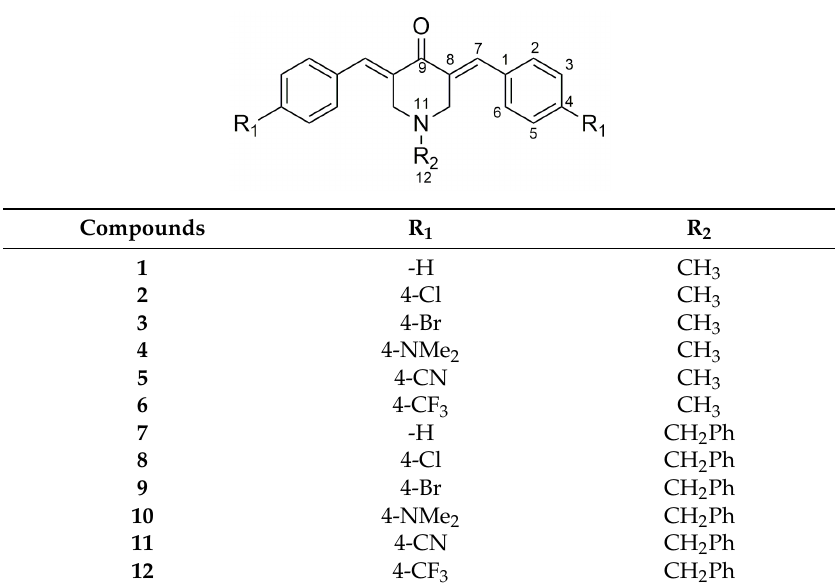
Table 1 . Molecules studied in this work.